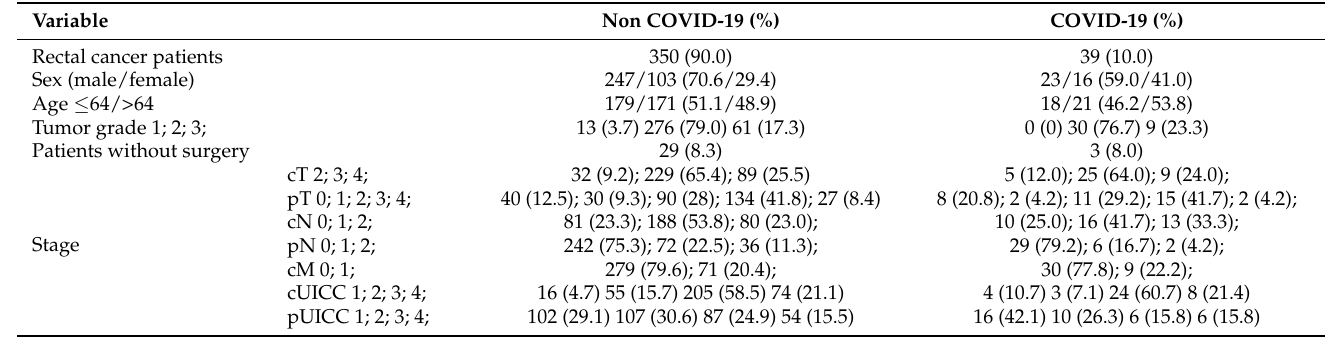
Table 1. Patient characteristics of the non-COVID-19 and the COVID-19